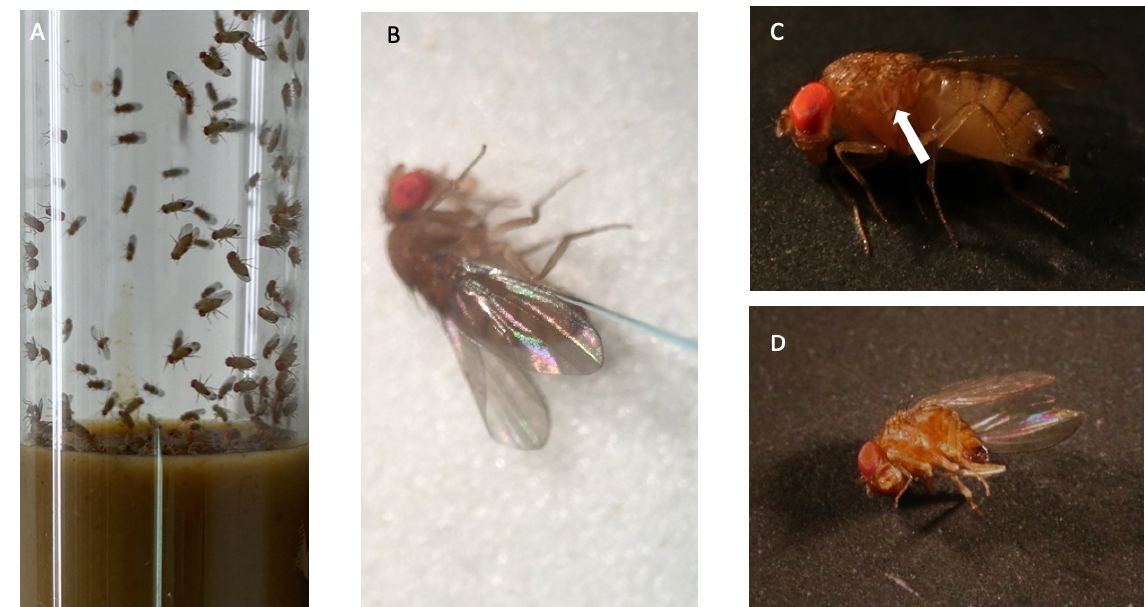
Figure 1. Production system for La Jolla virus strain LJV-Ds-OS20. ( A ) Culture of D. suzukii in a 2.5 cm diameter plastic tube containing soybean and cornmeal medium. ( B ) Microinjection with LJV-Ds-OS20 results in ( C ) melanization at the injection site (arrow) the day after the procedure and then ( D ) death of the infected fly 3 days later.